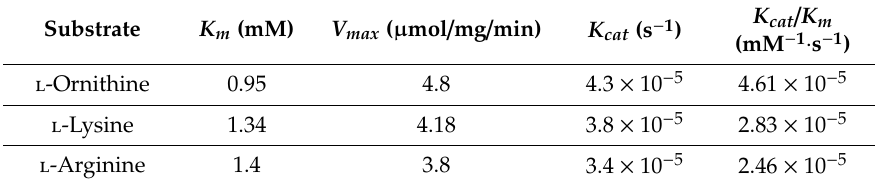
Table 4. Kinetic properties of A. terreus ODC for l -ornithine, l -lysine and l -arginine.